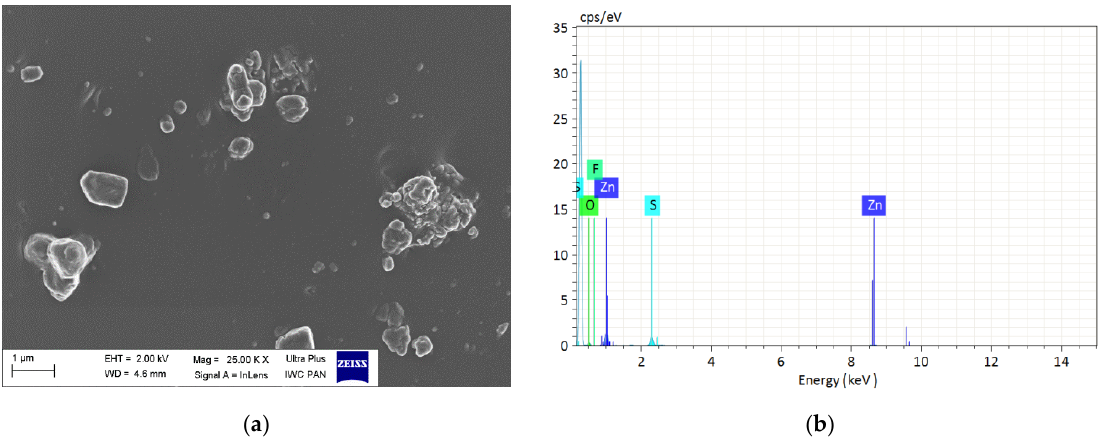
Figure 19. Dispersion of curatives in EPDM vulcanizate without ionic liquid: ( a ) Scanning electron microscopy (SEM) image; ( b ) Energy-dispersive X-ray spectroscopy (EDS) analysis.